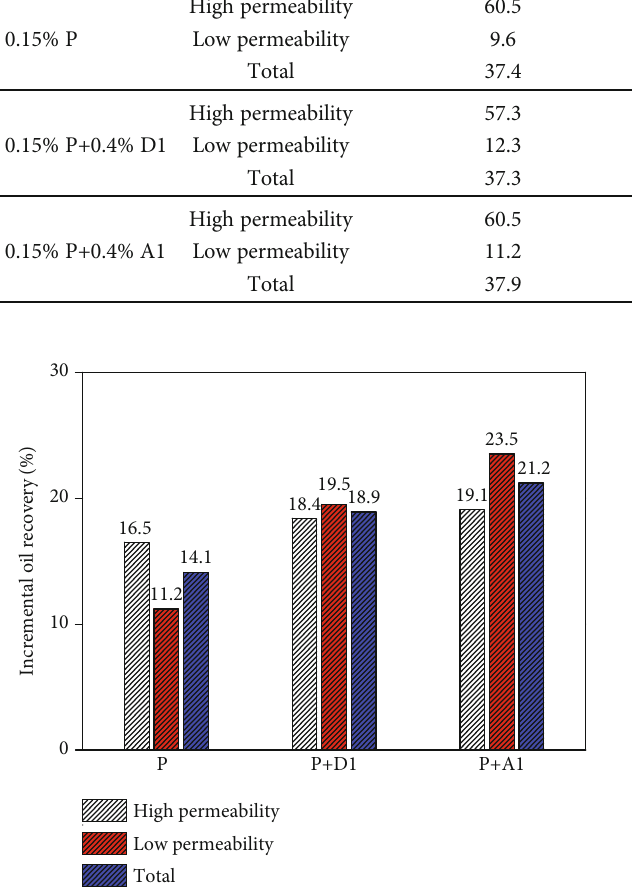
Figure 11: The incremental oil recovery results of polymer fl ooding and polymer-viscosity reducing surfactant fl